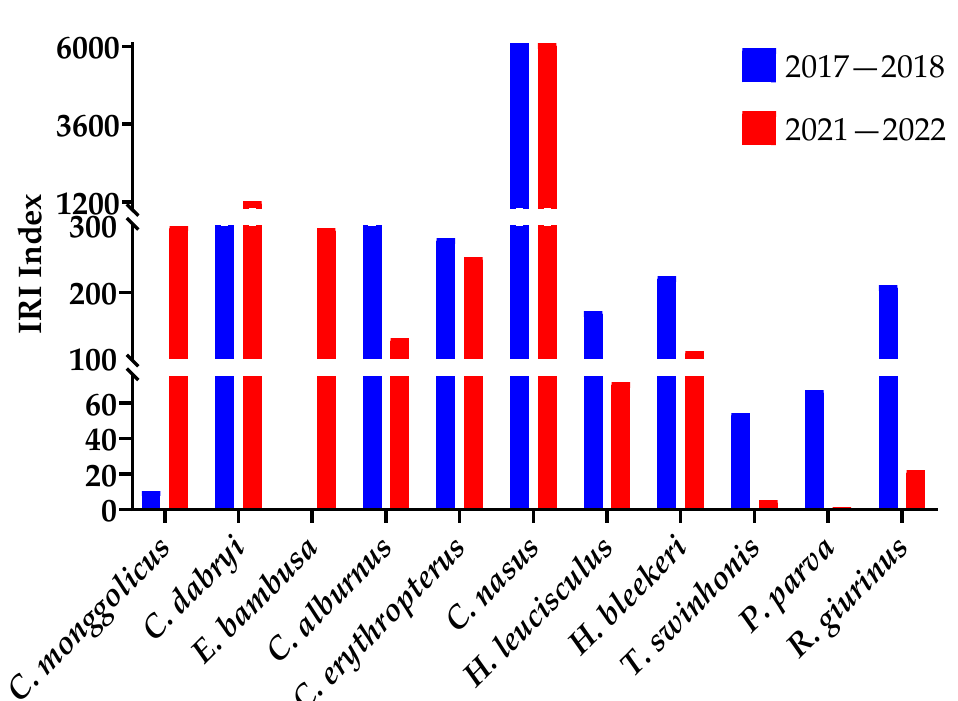
Figure 4. The IRI for carnivorous and small fish at the northern reserve in Gehu Lake in 2017–2018 and 2021–2022. Table 3. The IRI and N % of fish in the northern conservation area of Gehu Lake in 2017–2018 and 2021–2022.